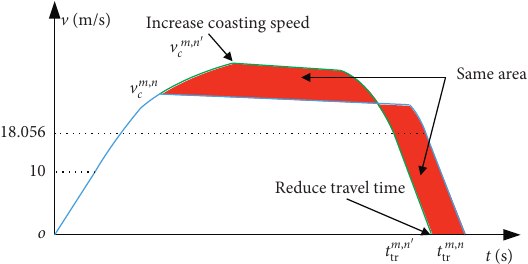
Figure 1: Relationship between coasting speed and travel